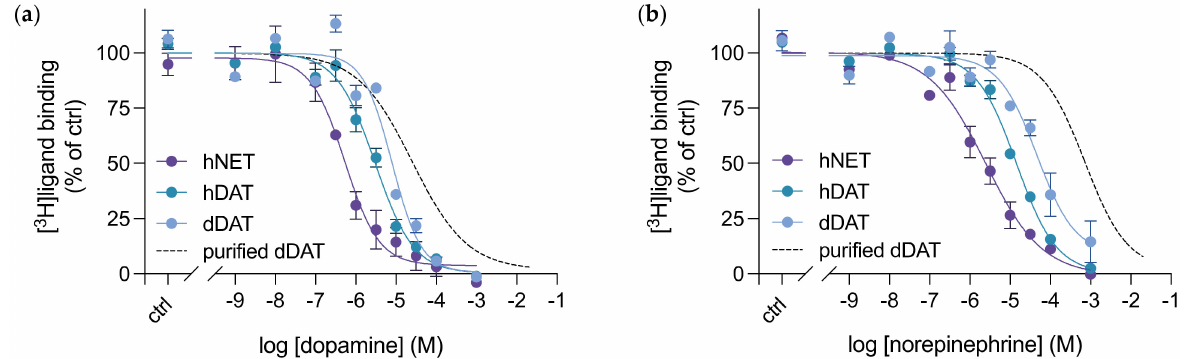
Figure 4. Competitive inhibition of radioligand binding to monoamine transporters in COS-7 cells by ( a ) dopamine and ( b ) norepinephrine. dDAT (blue circles), hDAT (green circles) and hNET (purple circles) were transiently transfected into COS-7 cells and underwent competitive radioligand binding. [ 3 H]nisoxetine was used in the radioligand assays for both dDAT and hNET, and [ 3 H]CFT was used in the radioligand assays for hDAT. The binding curves established are compared to dopamine and norepinephrine binding in purified dDAT (black dashed line), whose data curve comes from Figure 3b. The K i values determined from these assays can be found in Table 1. All data points represent mean ± SEM, n = 3–5 from independent transfections of COS-7 cells. ctrl (control): [ 3 H]ligand binding in the absence of the competitive